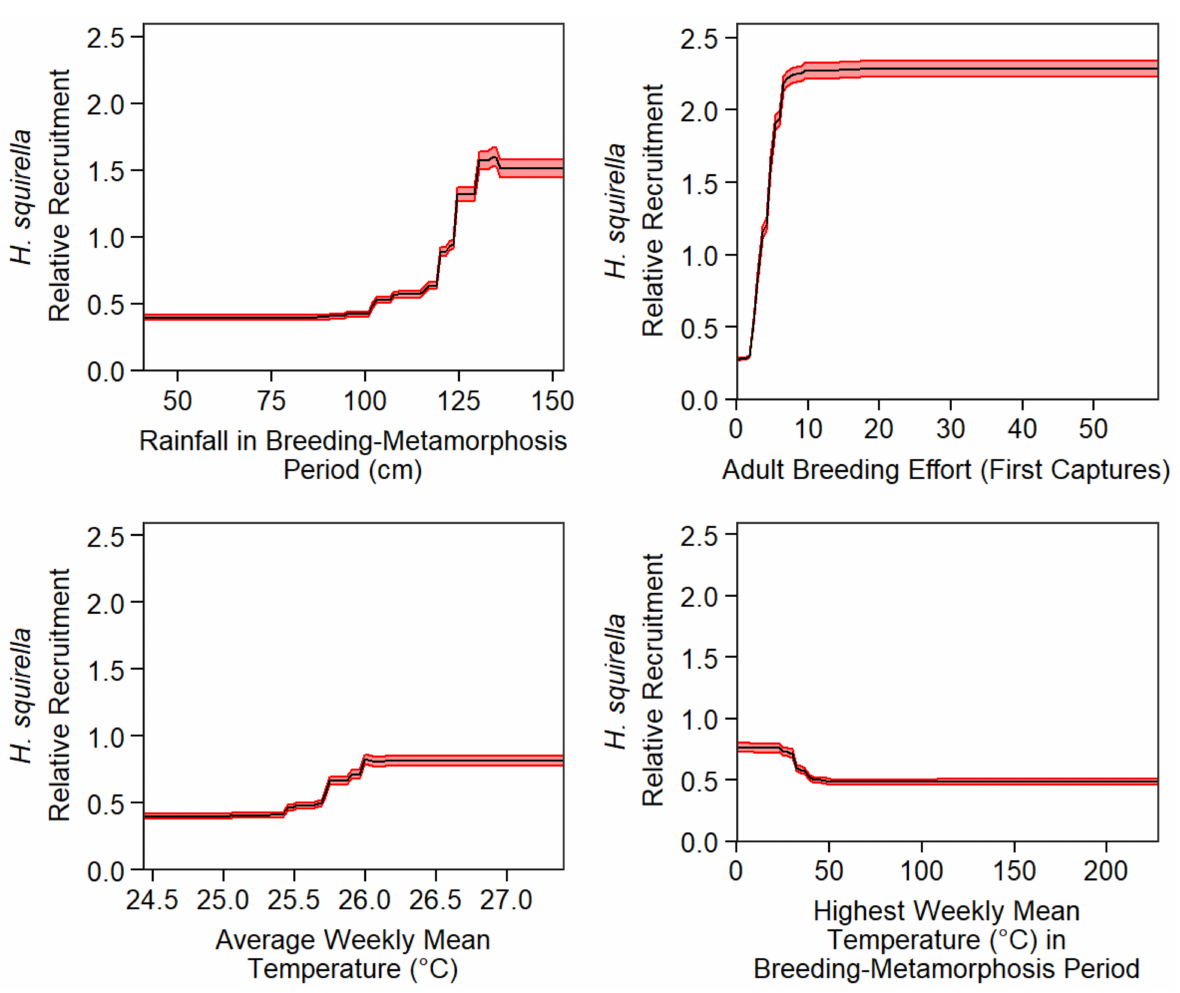
Figure 7. Influences of the four most important predictor variables (excluding pond ID) on relative annual H. squirella recruitment, Ocala National Forest, Marion County, Florida. Black lines represent mean predictions using BRTs; red ribbons represent standard errors. Table 2. Correlations (r) between observed annual values of each of our Phase I predictor variables (1994–2017) and values predicted by Bioclim variables in Phase II using LASSO models,